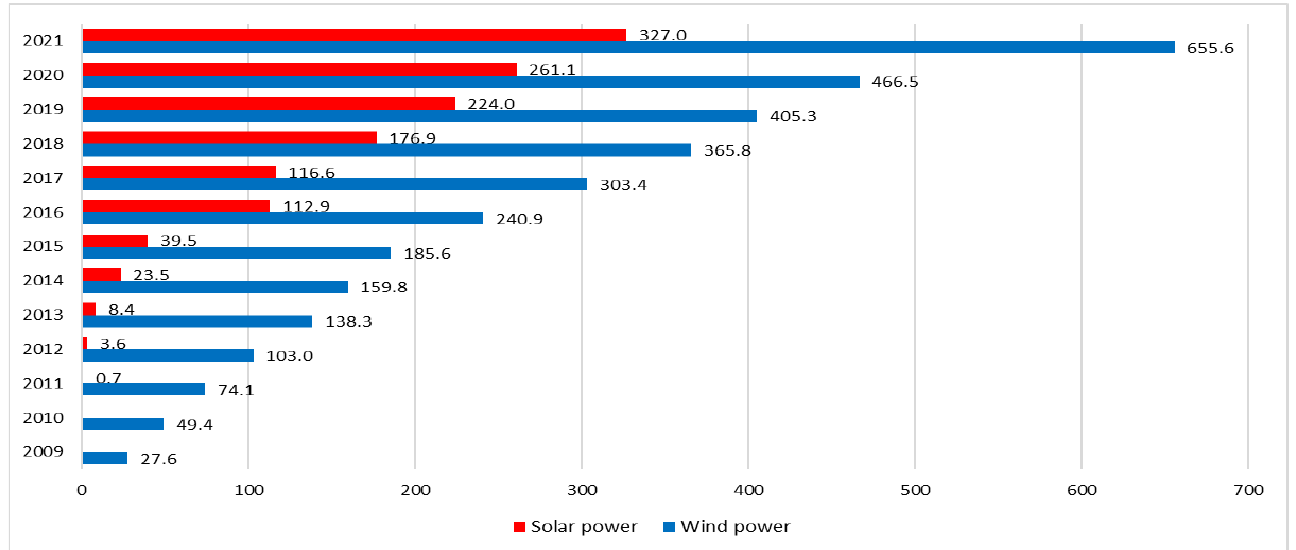
Figure 4. Electricity generated by wind and solar energy in China (unit: TWh). Notes: The data for solar power in 2009 – 2010 are not available due to the dataset’s negligible size. Source: China Elec- tricity Council, Statistical Digest of China’ s Electricity Industry, various issues, available at https://cec.org.cn/menu/index.html?542 (accessed on 31 December 2022).